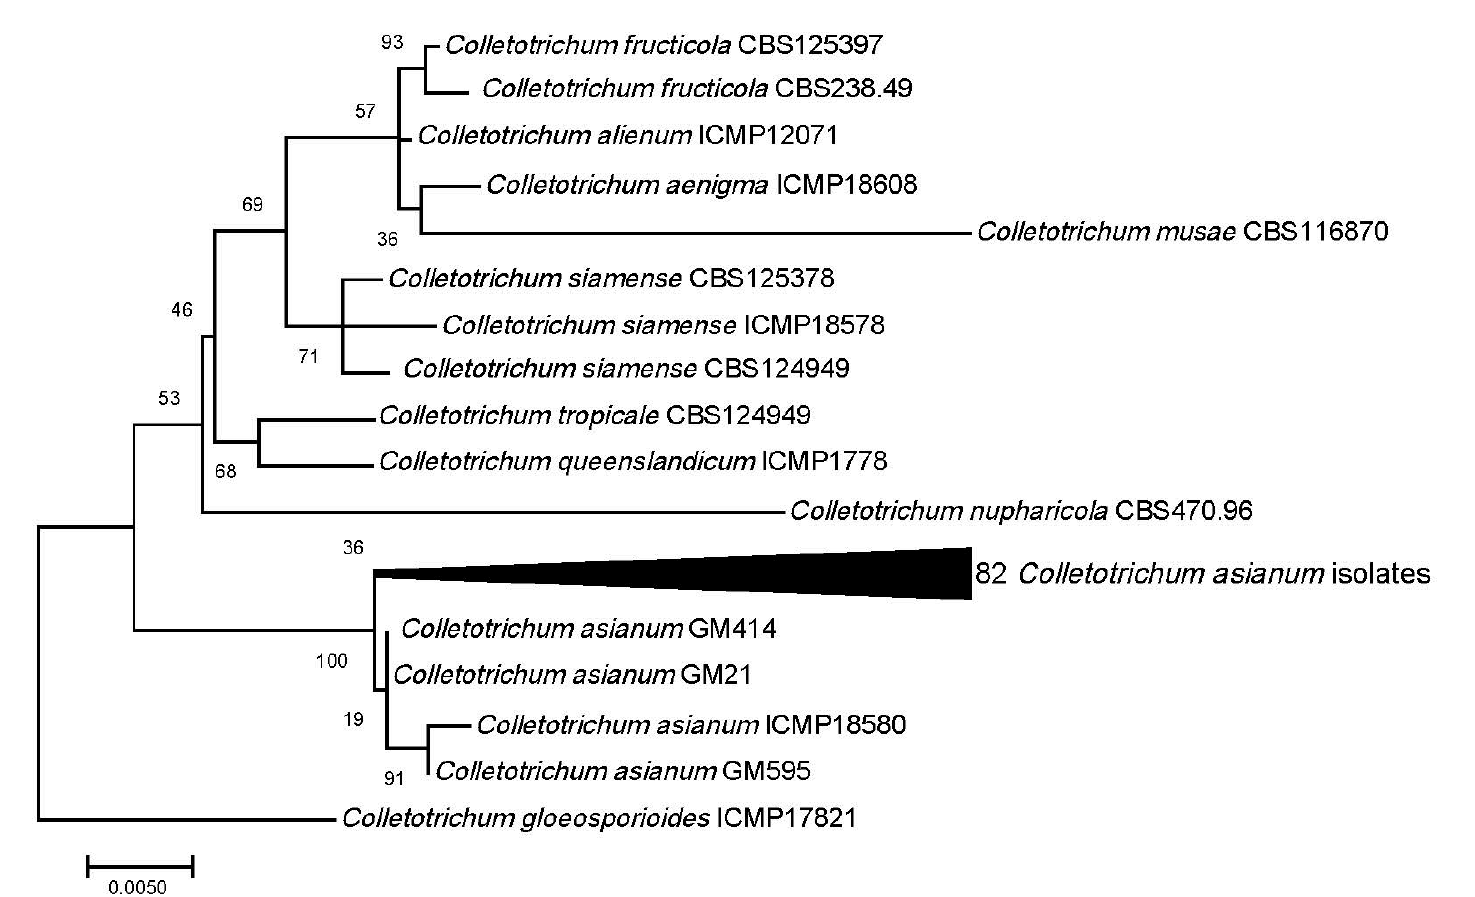
Figure 2. Three loci (ITS, TUB, HIS) phylogeny of the 82 C. asianum isolated from Mangifera indica in the Brazilian Mango Germplasm Collection at the Sementeira Farm, Universidade Federal de Viçosa in southeastern Brazil.